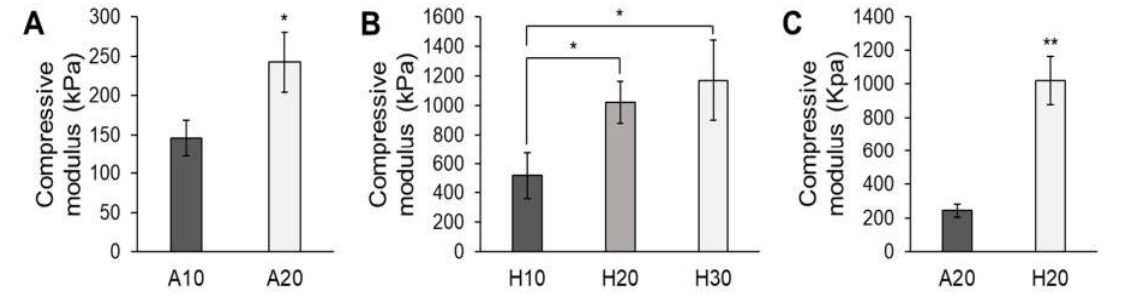
Figure 8. Compressive modulus values of ( A ) aqueous and ( B ) HFIP-based SF scaffolds. ( C ) Com- parison of the compressive modulus values of the 20% aqueous and HFIP-based SF scaffolds. The mechanical strength of the SF scaffolds increased with increasing SF concentration. The HFIP-based SF scaffold showed higher mechanical strength than the aqueous-based SF scaffold (* p < 0.01, ** p < 0.005).